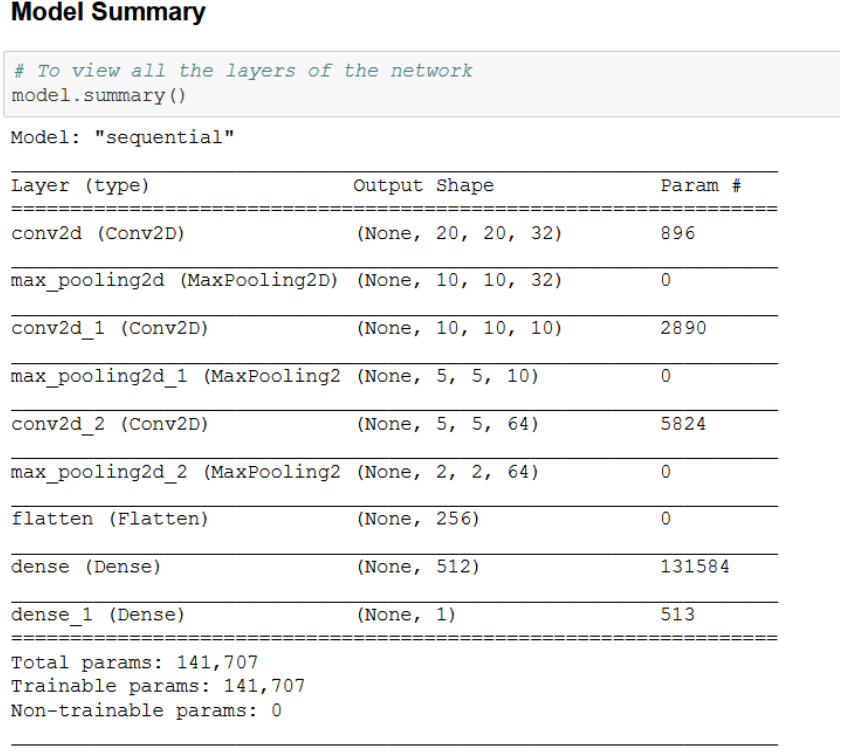
Figure 5 . The proposed model summary . Figure 5. The proposed model